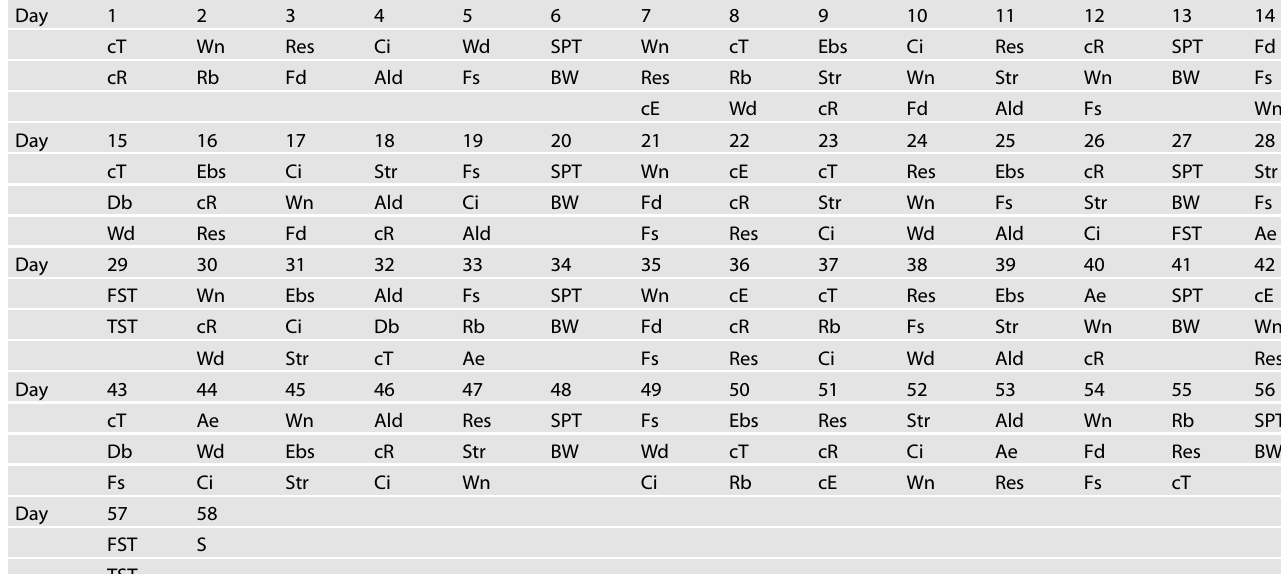
Table 2. Protocol for